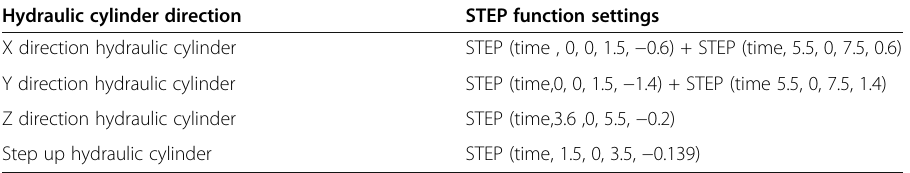
Table 6 Specific settings of STEP function driven by each hydraulic cylinder Hydraulic cylinder direction STEP function settings